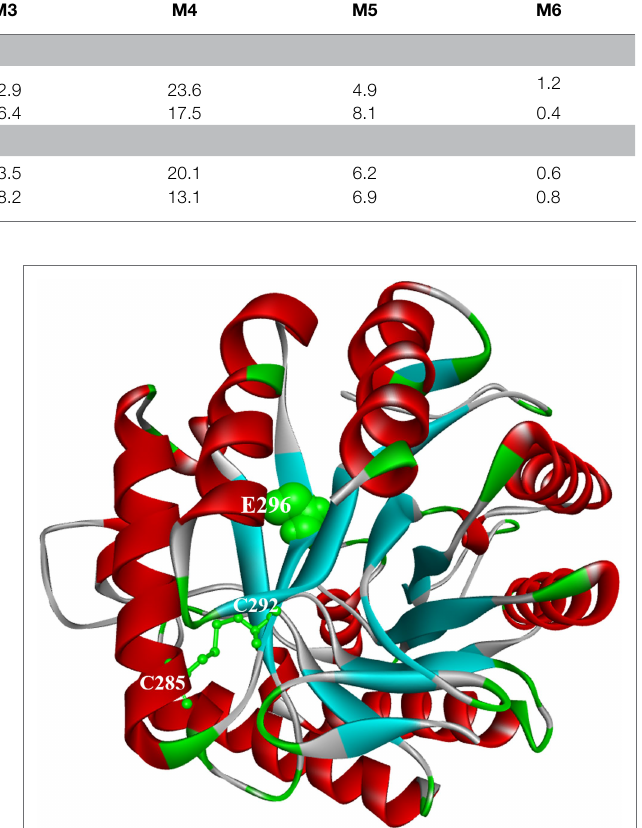
TABLE 3 | High-performance liquid chromatography analysis of the hydrolysis products of mannan polymers by ManAK and ManAK L293V . Composition (%) of products formed by hydrolysis reaction Substrate